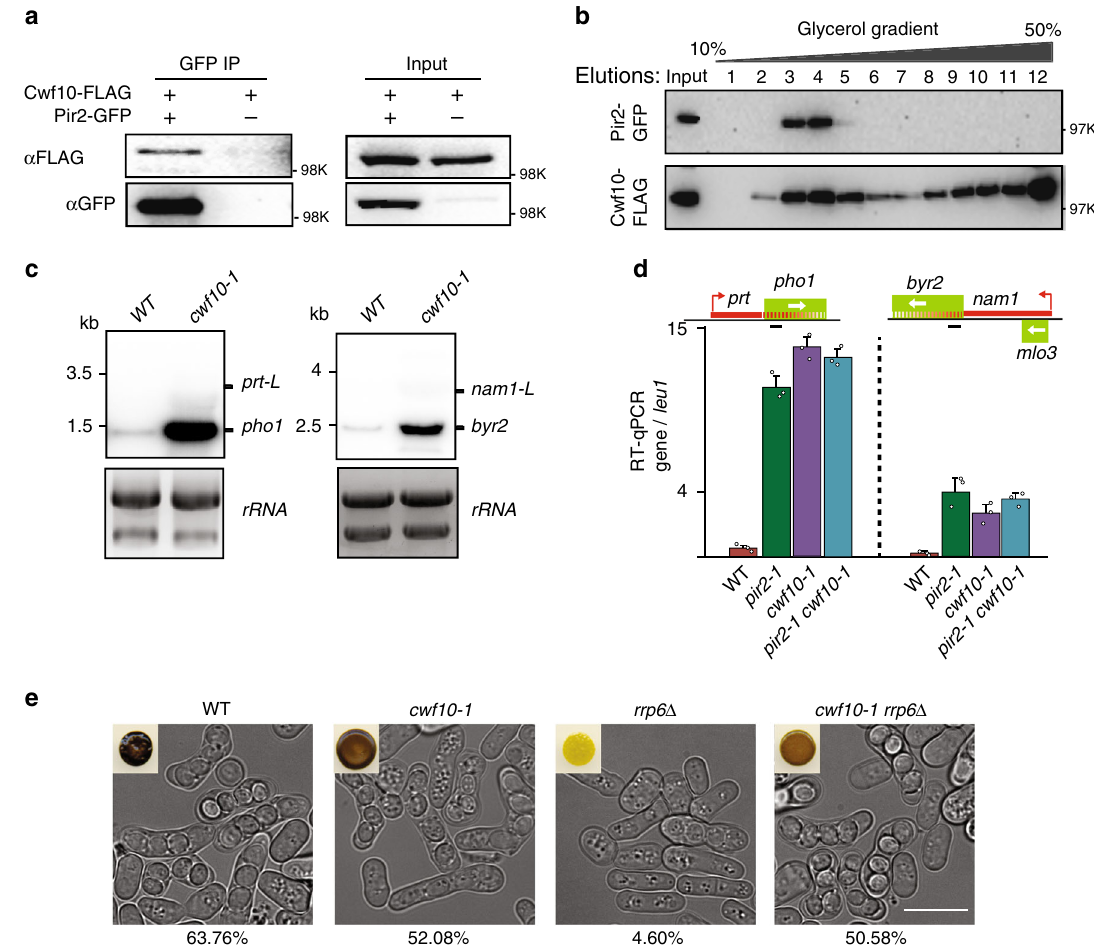
Fig. 2 Splicing machinery bound to Pir2 mediate gene repression by lncRNA. a Co-IP analysis of Pir2-GFP with Cwf10-FLAG proteins. Source data are provided as a Source data fi le. b Glycerol gradient analysis. Elution fractions are indicated above the gel. Source data are provided as a Source data fi le. c Northern blot analysis of transcripts produced from the pho1 and byr2 loci. Probes are described in Fig. 1a. Source data are provided as a Source data fi le. Cells were grown in YEA medium. d RT-qPCR analysis of pho1 and byr2 expression, normalized to leu1 . The ampli fi ed regions are indicated by the black lines. Data are presented as mean values ± SD for n = 3 biologically independent samples. Mean data distribution is represented by white circles. e Representative DIC images of homothallic (h 90 ) WT and mutant strains. The sporulation frequency is indicated as a percentage ( n > 1000). Insets show colonies stained with iodine vapor. Indicated white scale bar represents 10 µ cwf10-1 double mutant as compared to the single mutants (Fig. 2d). Importantly, cwf10-1 rescued the sporulation defect observed in rrp6 Δ caused by the silencing of the byr2 gene by nam1 lncRNA (Fig. 2e), similar to pir2-1 (Fig. 1f). These results con fi rm the biological signi fi cance of Pir2 association with splicing machinery and show that these factors collaborate to promote gene repression by lncRNAs.